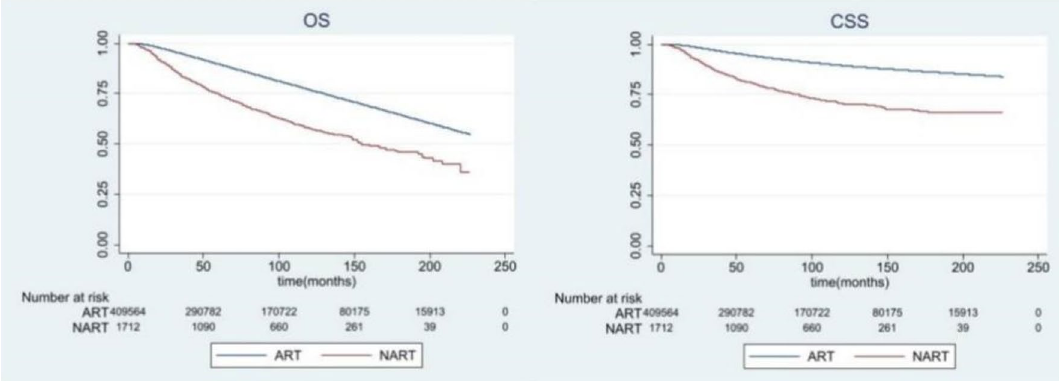
Figure 1. Overall and breast cancer-specific survival by radiation sequence with surgery among the whole